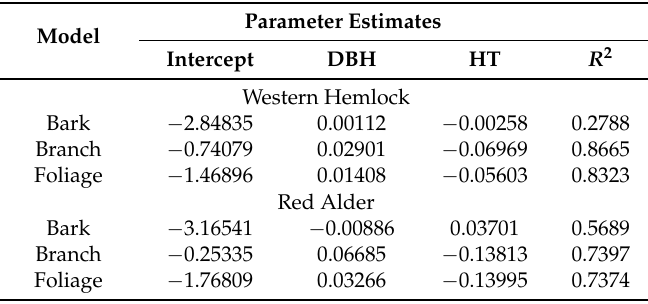
Table 7. Parameter estimates for the component biomass models for Western hemlock and red alder trees from using the Dirichlet regression. Component bole was used as reference group for both